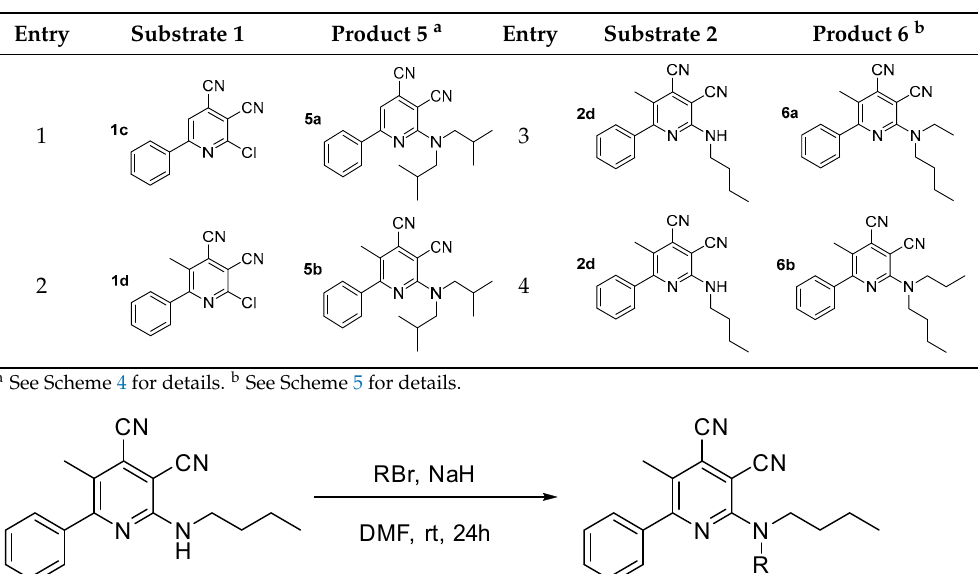
Figure 11. UV-vis absorption (5 × 10 –5 M, solid line) and emission (5 × 10 –5 M, dashed line) spectra of compounds 2d, 3d, 4d, 6a, and 6b in toluene. The solid-state photoluminescence spectra of compounds 2d , 3d , 6a , 6b, and 4d, con- taining various substituents at the nitrogen atom of the amino group, were characterized by emission maxima in the range of 483–519 nm. Compound 2d, with a free NH fragment was the most intense, similarly as in solution. The introduction of an alkyl substituent into the amino group led to a bathochromic shift in the emission band and caused a decrease in its intensity (Table 3, Figure 12).